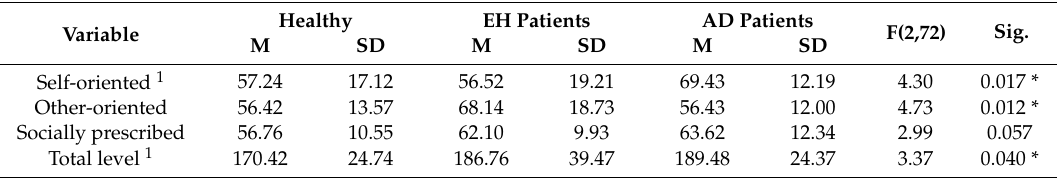
Table 1. Di ff erences in levels of